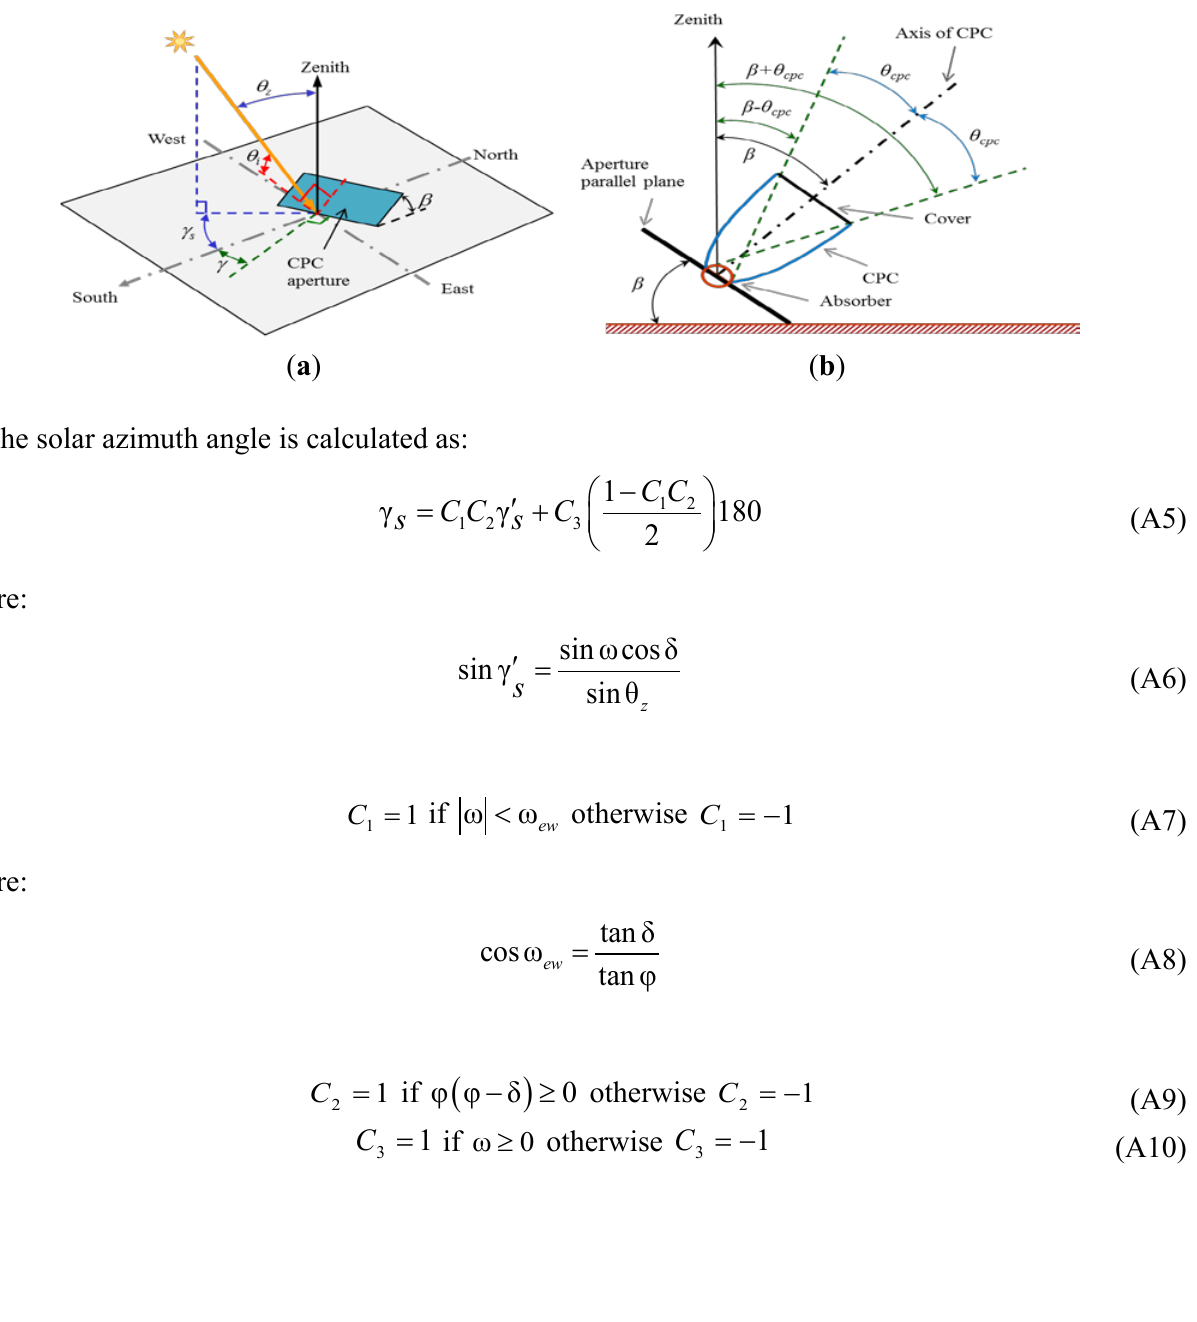
Figure A1. Description of angles ( a ) solar and collector angles and ( b ) projection on a north-south plane of CPC acceptance and tilt